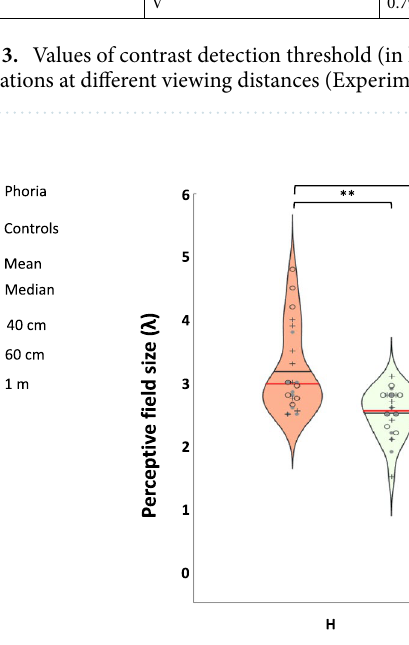
Figure 2. The violin plots represent the distribution of the perceptive field size for the horizontal (H) meridian (the orientation of a target of 0°) and the vertical (V) meridian (the orientation of a target of 90°). The phoria group (n = 8) is denoted in dark orange and the control group (n = 8) is denoted in light green. The results were obtained in Experiment 1. Each violin plot contains the results of all three viewing distances. ***p ≤ 0.001, **p ≤ 0.01, *p ≤